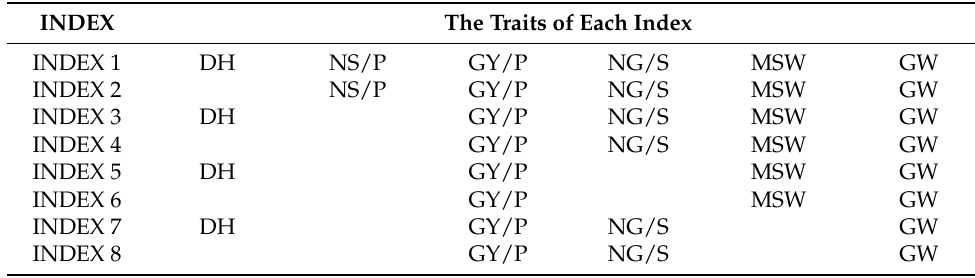
Table 7. The traits involved in the eight